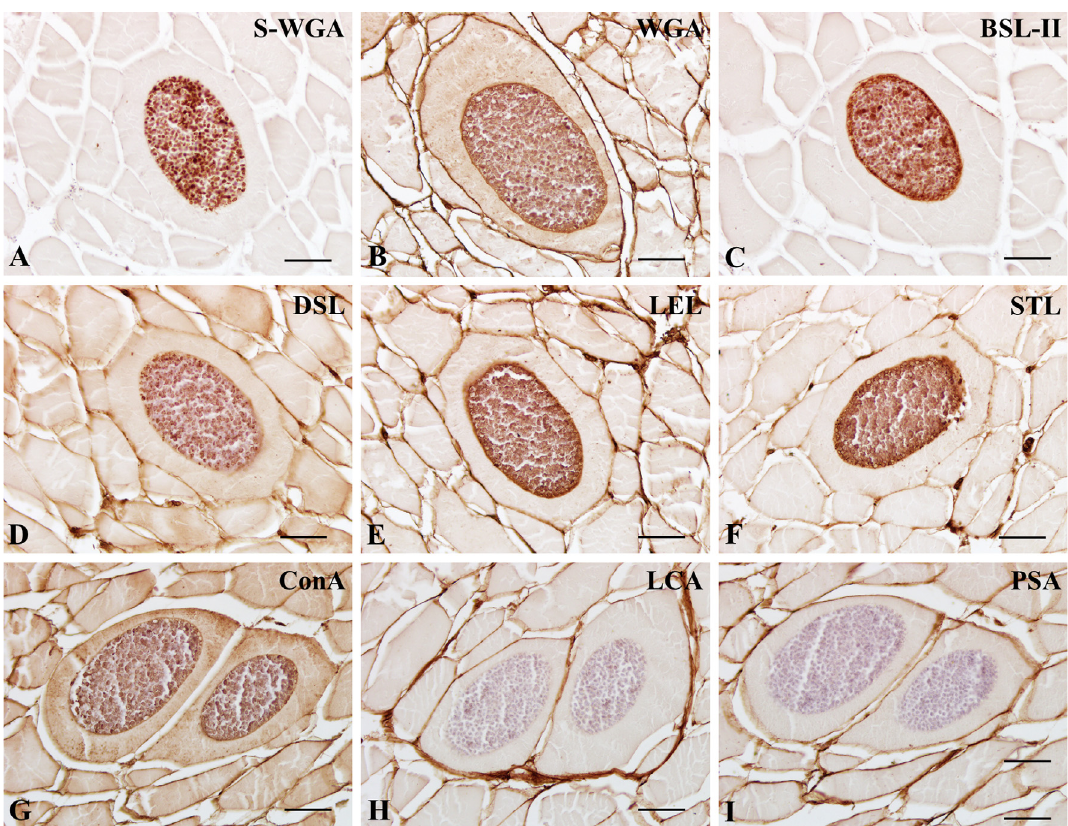
Figure 2. Lectin histochemical findings of N-acetylglucosamine (S-WGA, WGA, BSL-II, DSL, LEL, STL) and mannose groups (Con A, LCA, PSA) in Kudoa septempunctata -infected muscles. A, S-WGA; B, WGA; C, BSL-II; D, DSL; E, LEL; F, STL; G, Con A; H, LCA; I, PSA. Scale bars in (A)–(I) represent 20 l m.